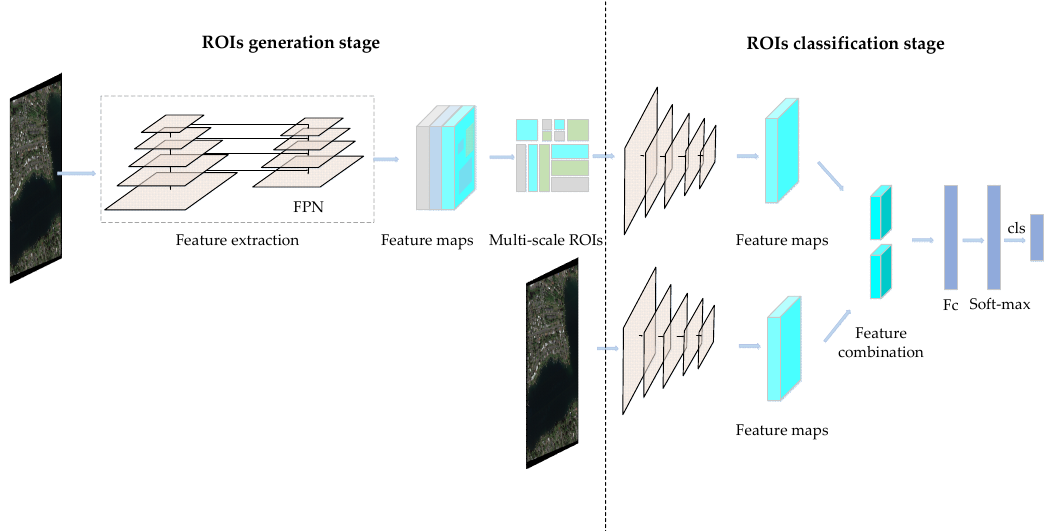
Figure 1. Framework of the proposed scene-contextual feature pyramid network (SCFPN). ROI: region of interest; FPN: feature pyramid network; Fc: fully convolutional layer; cls: classification.